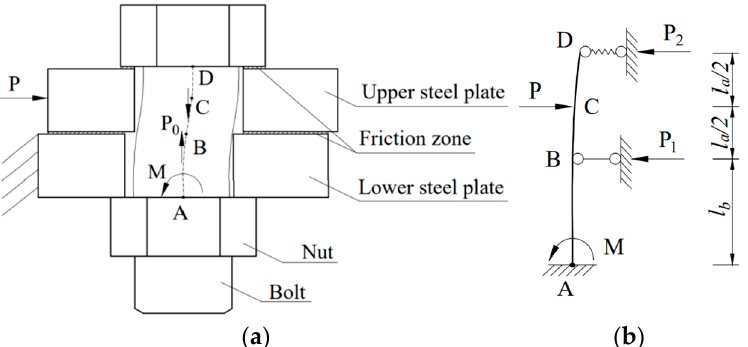
Figure 2. Mechanical model and mechanism diagram of bolt: ( a ) Load loading diagram; ( b ) Bolt deformation equivalent model diagram.